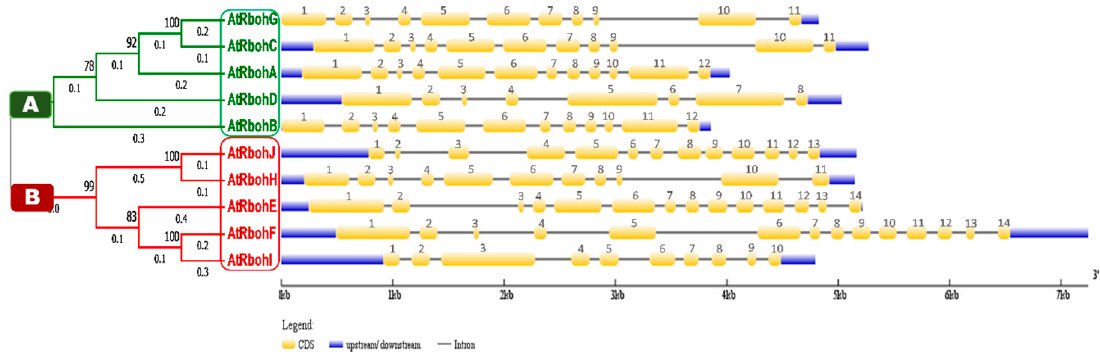
Figure 10. Phylogenetic analysis in line with intron-exon structure analysis of Arabidopsis Rboh genes. Phylogenetic tree is classified into group A and B, which are labeled by green and red boxes, respectively. Scale provided at the bottom of the figure compares the length of gene in 1000 base pairs (kbp). Golden, blue and thin grey colored lines show positions of exons, UTRs and introns,